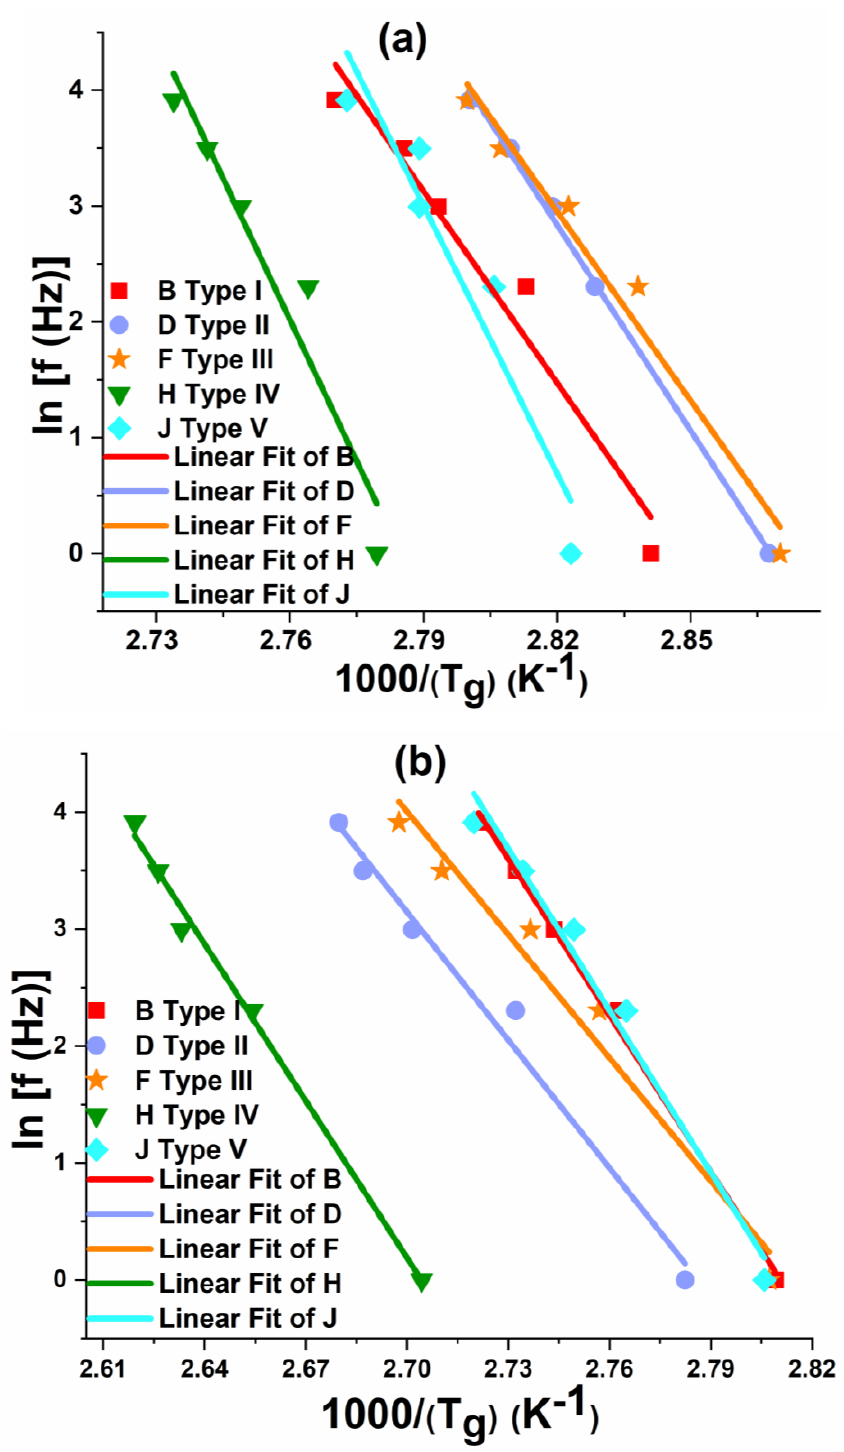
Figure 18. Effect of frequency on T g of CFRP composites: ( a ) loss modulus and ( b ) Loss tangent. Figure 18. E ff ect of frequency on T g of CFRP composites: ( a ) loss modulus and ( b ) Loss